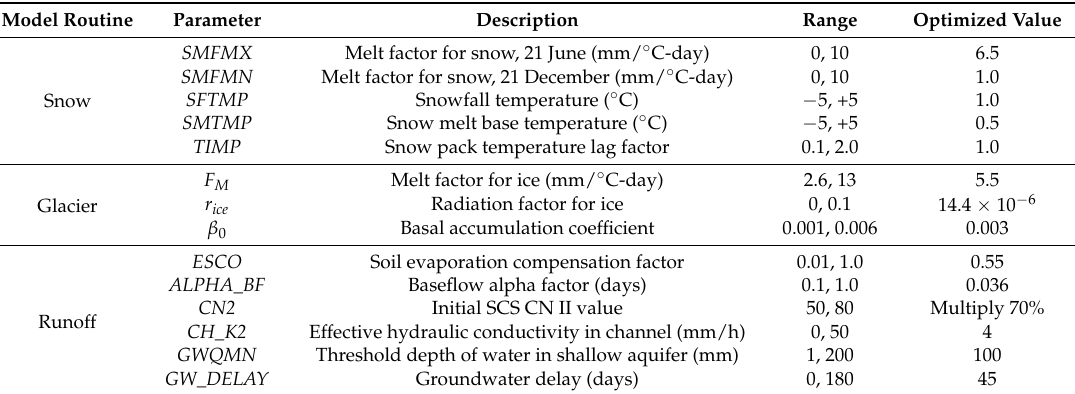
Table 3. Monthly streamflow (m 3 ·s − 1 ) calibration and validation results for Yarkant River Basin (YRB), Northwest China. NSE : Nash–Sutcliff Efficiency; RSR : Root mean square error-observations standard deviation ratio; PBIAS : percentage bias.